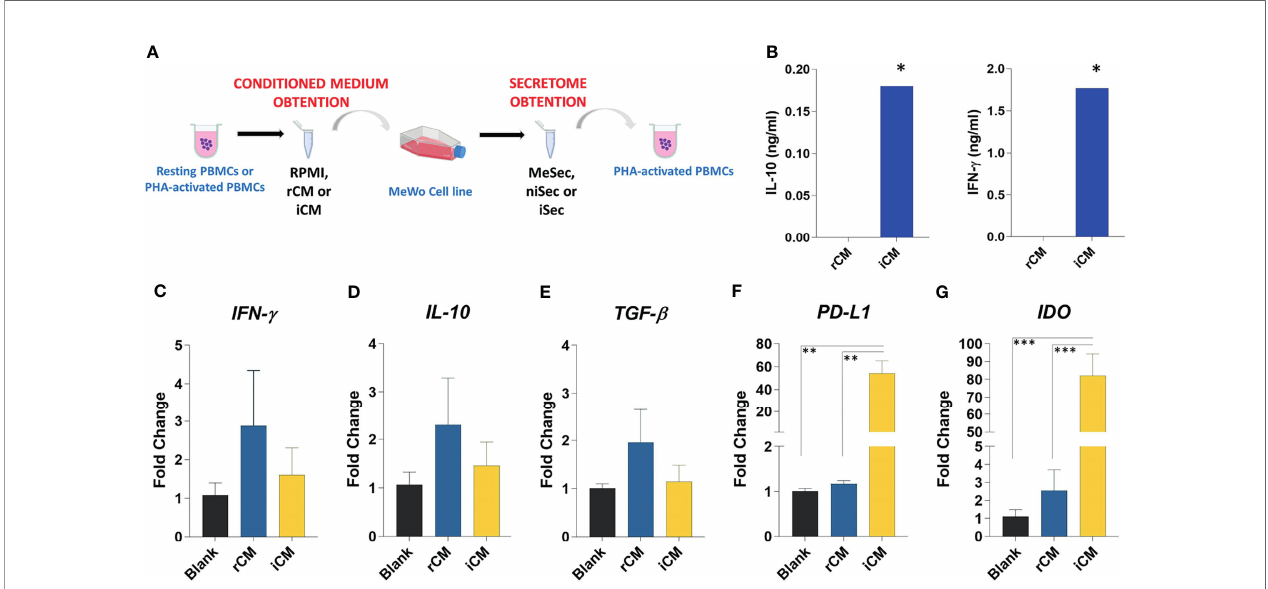
FIGURE 1 | Experimental schedule, characterization of conditioned media and gene expression analysis in MeWo. (A) PBMCs were isolated and cultured for 72 hours as resting PBMCs or PHA-activated PBMCs. Further the conditioned medium (RPMI, rCM, and iCM) was obtained and utilized to promote MeWo expansion. When the cell line reached 70% con fl uence, the media were removed, the cells were washed three times in PBS and cultured for 24 hours in RPMI medium 10% FBS. After this period, the media were aliquoted and used as secretome from melanoma previously submitted to RPMI (MeSec), non-in fl ammatory (niSec), and in fl ammatory stimulus (iSec). The immunomodulatory effects of these secretomes were tested in PHA-activated PBMCs. (B) IL10 and IFN- g levels were assessed by ELISA in pooled rCM and iCM. The pools comprised samples obtained from 4 donors. (C) IFN- g , (D) IL-10 , (E) TGF- b , (F) PD-L1 and (G) IDO expression were assessed in MeWo stimulated by RPMI 10% FBS (Blank), rCM and iCM. Results are presented as mean ± SEM of three independent experiments. *p < 0.05, **p < 0.01, ***p <